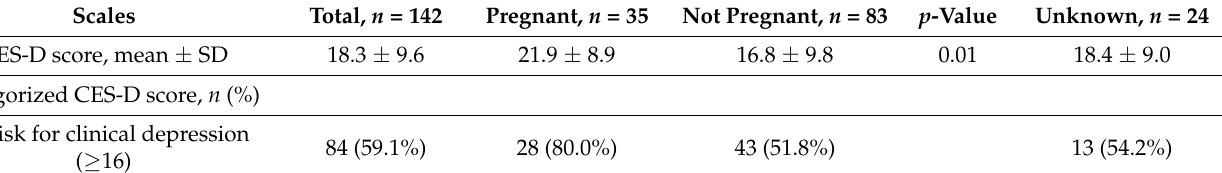
Table 2. Depression, stress and anxiety scale scores between pregnant and not pregnant